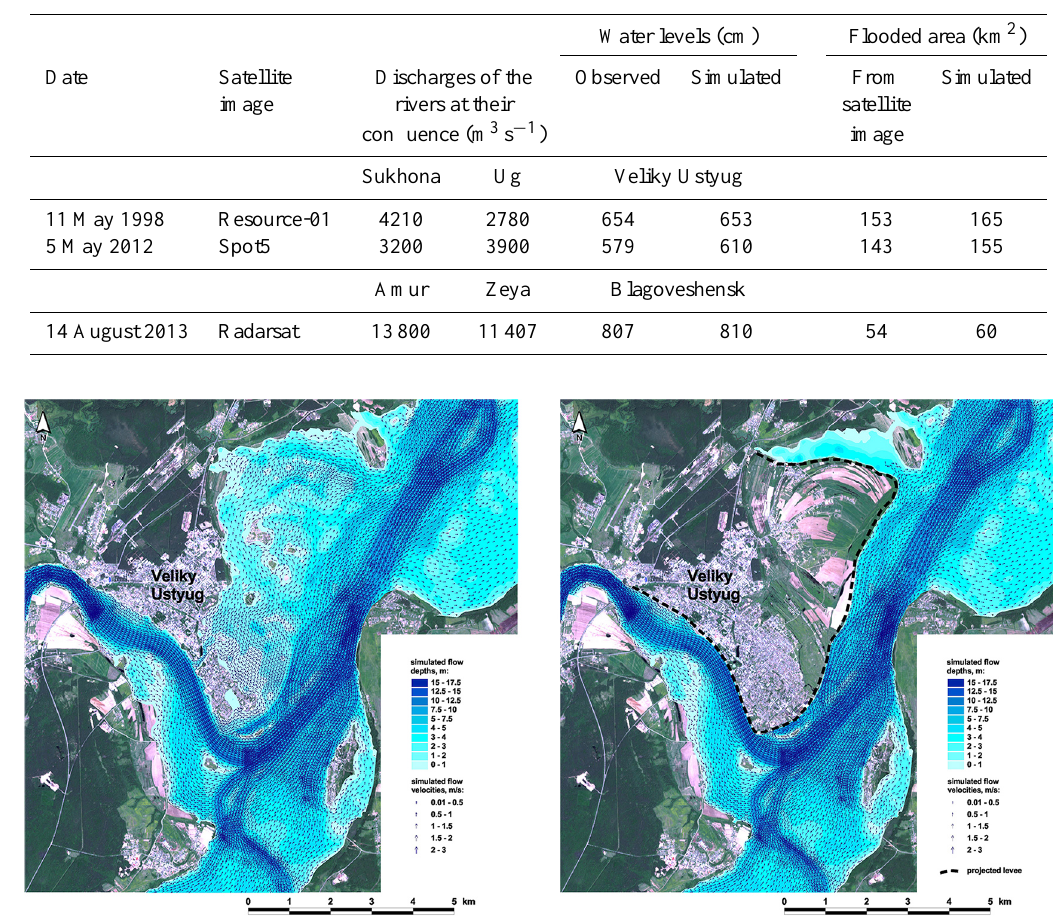
Table 1. Results of model validation.